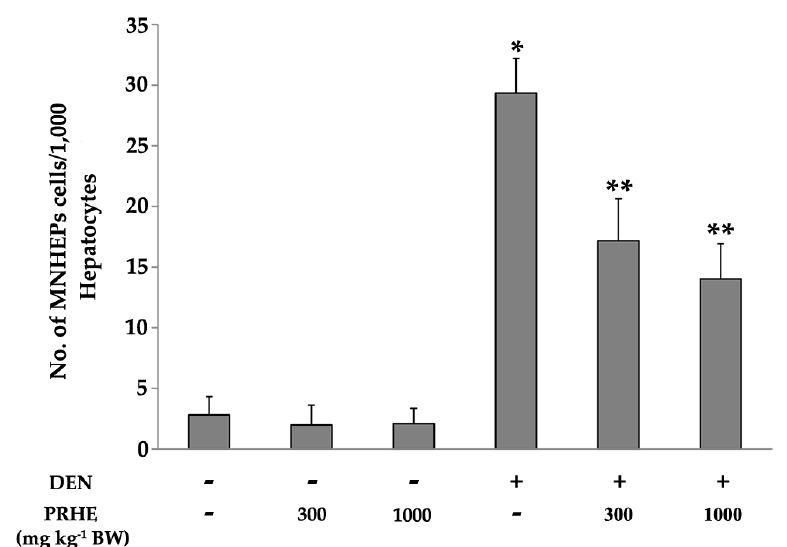
Figure 2. Clastogenicity and anticlastogenicity of PRHE in the liver of DEN-initiated rats. Value are expressed as mean ± SD. DEN: diethylnitrosamine 30 mg kg − 1 body weight (BW), i.p. MNHEPs: micronucleated hepatocytes. PRHE: purple rice husk extract. * Significantly different from normal saline solution (NSS) group, p < 0.05. ** Significantly different from DEN group, p < 0.05.